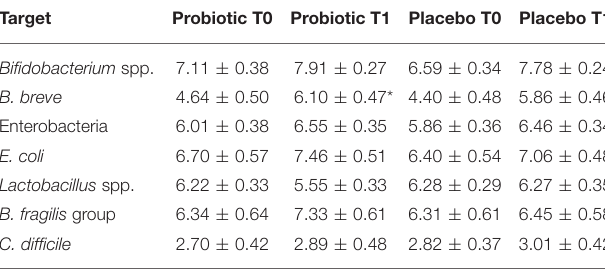
TABLE 6 | Mean counts (Log CFU/g of faeces) of different microbial groups analyzed in stool samples of breast-fed newborns.